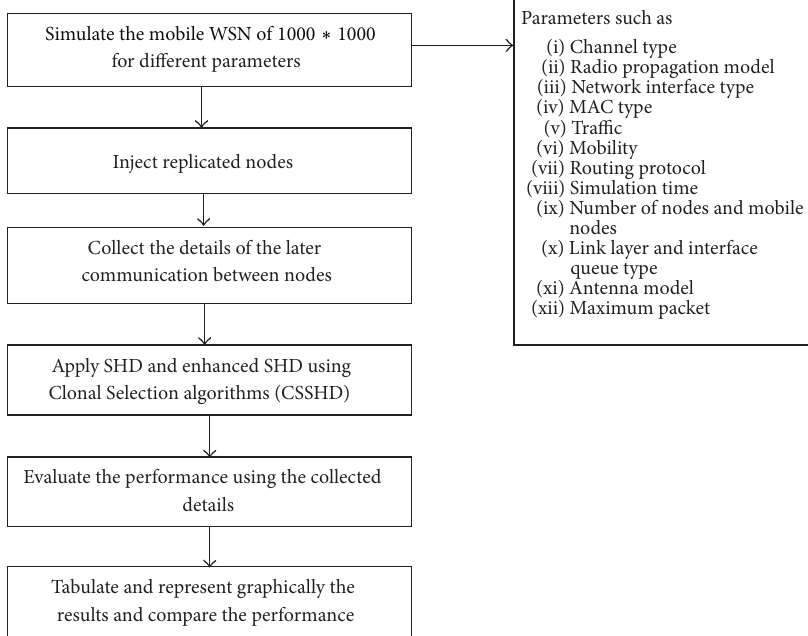
Figure 3: Simulation methodology.